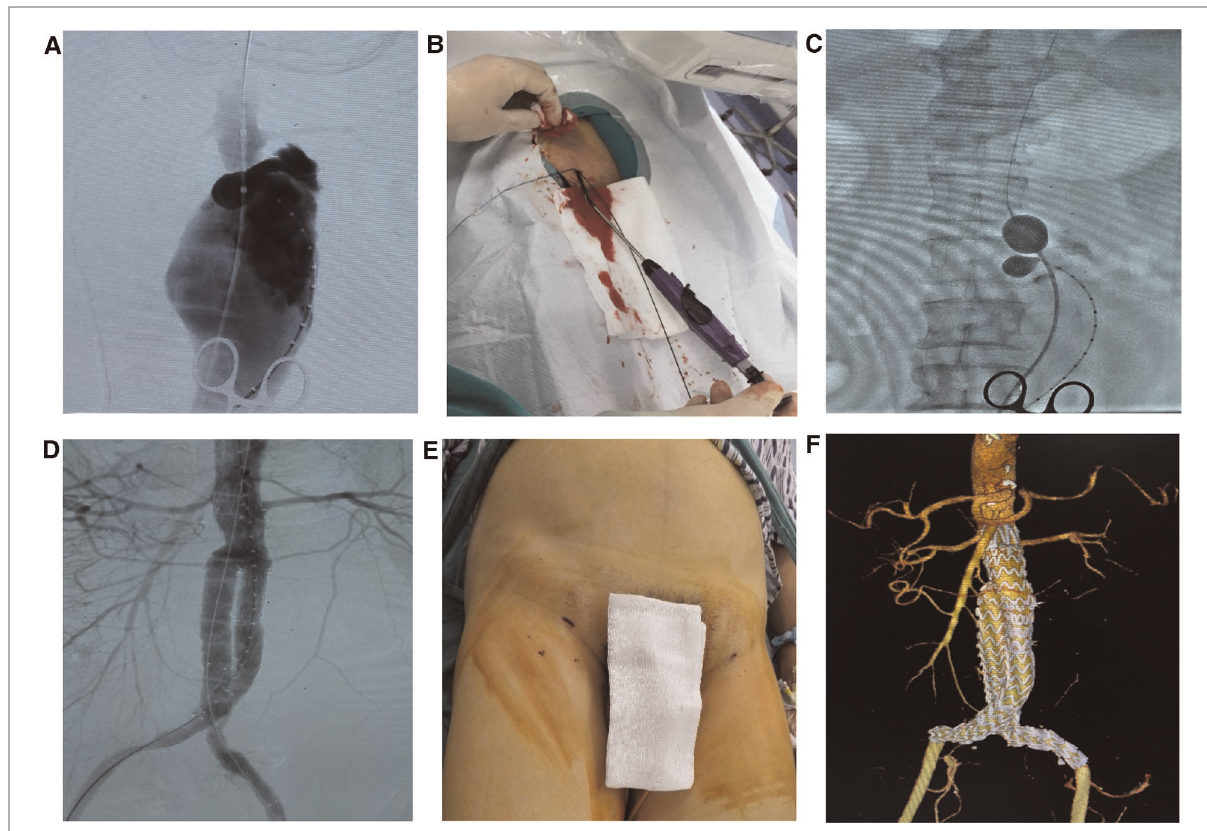
FIGURE 2 Ruptured percutaneous (rPEVAR) operative procedure ( A ) angiogram of ruptured AAA. ( B ) Percutaneous cannulation and deployment of ProGlide devices in the bilateral CFAs. ( C ) A stiff Lunderquist wire and a12Fr 45 cm sheath were advanced to the perivisceral aorta then a Coda balloon was advanced through the sheath and in fl ated in the distal thoracic aorta. ( D ) EVAR was performed. ( E ) The sheaths were removed and the femoral cannulation sites were closed using the pre-deployed ProGlide devices. ( F ) Follow-up 3D CTA 30-day post